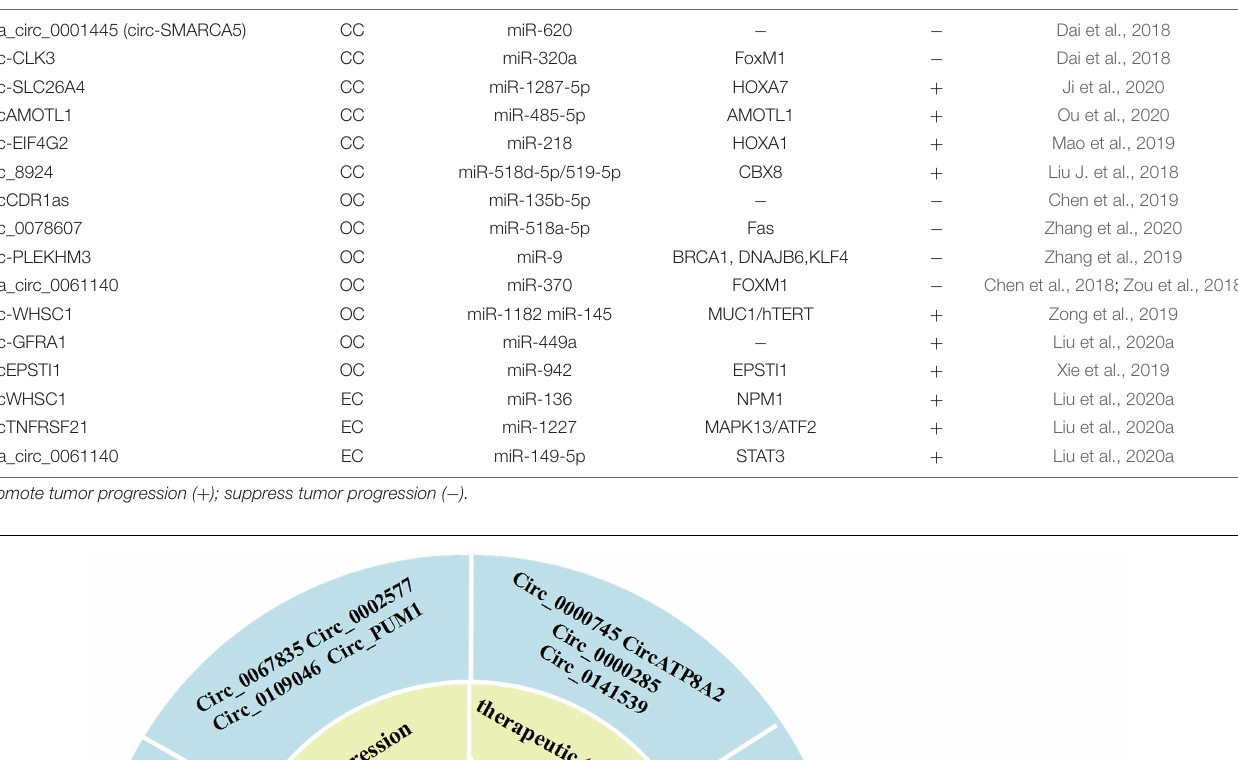
TABLE 4 | CircRNAs suppress and promote gynecological tumors progression. Circular RNAs Gynecological cancers miRNA Cancer expression target gene Function